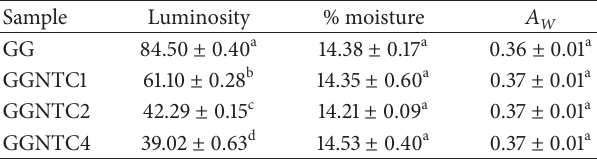
Table1:Luminosityfactor( 𝐿 ∗ ),moisturecontent,andwateractivity of films from gelatin/glycerol and carbon nanotubes ∗